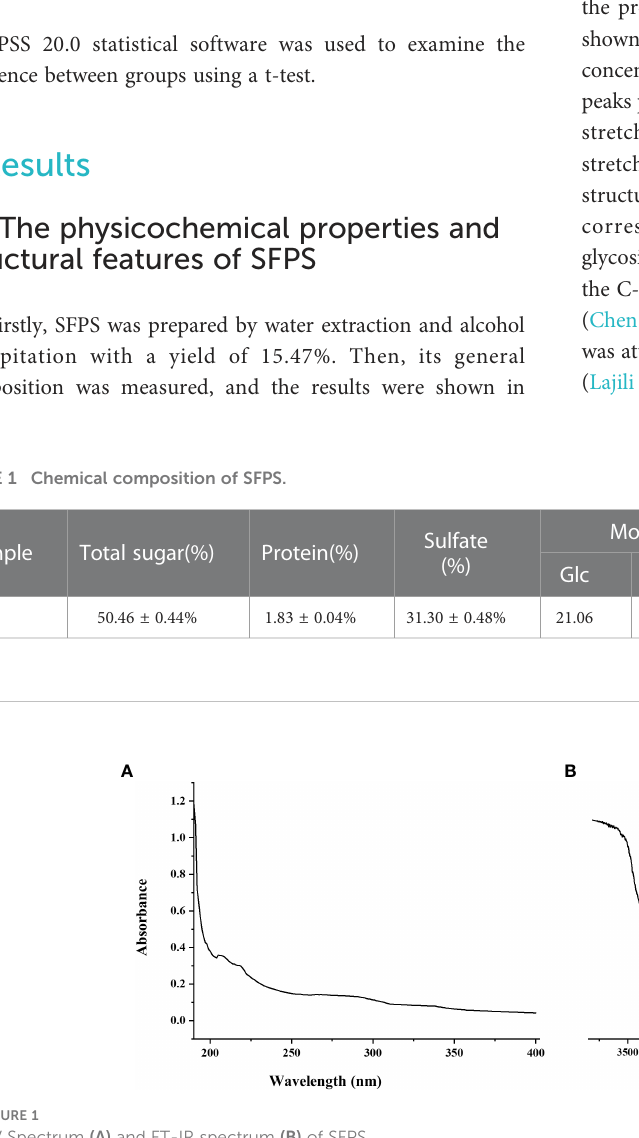
galactose (Gal), mannose (Man), rhamnose (Rha), and xylose